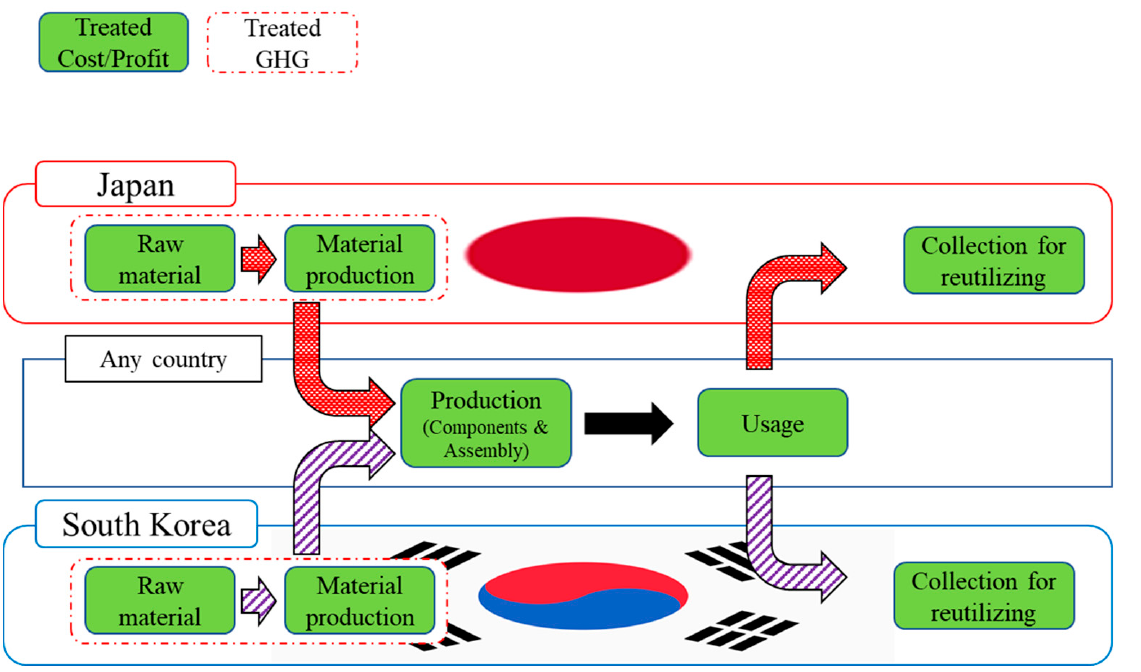
Figure 2. System boundary: Treated GHG emissions are inside the dotted red line while addressed cost and profit are in the green boxes.